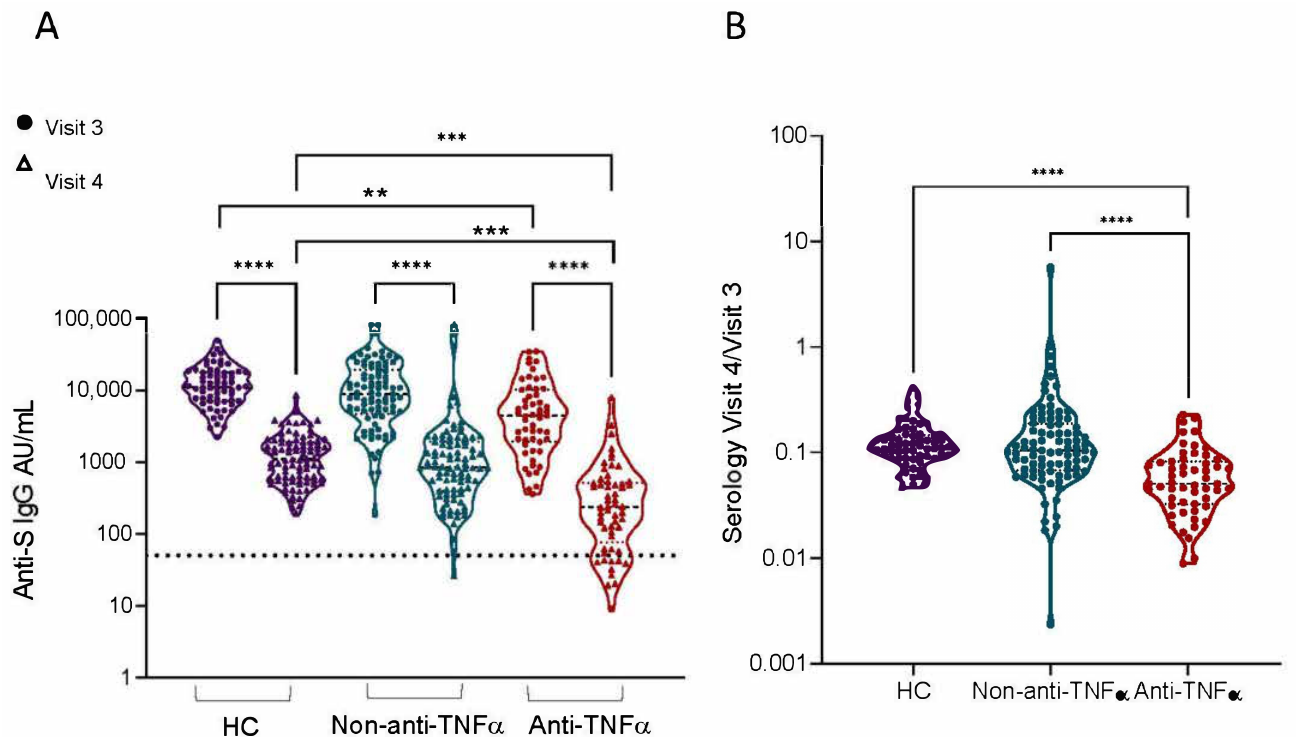
Figure 2. Patients with IBD treated with anti-TNF α showed significantly reduced levels of anti- S levels 6 months after two BNT162b2 vaccine doses. ( A ) Levels of anti-S levels in sera from healthy controls (HCs, shown in purple), patients with IBD receiving non-anti-TNF α treatment (non-anti-TNF α , shown in blue) and patients with IBD receiving anti-TNF α treatment (anti-TNF α , shown in red). Antibodies were measured with the Abbott quantitative anti-S IgG kit. Visits 3 (filled circles) and 4 (open triangles)—after two vaccine doses, 1 and 6 months, respectively. Statistical analysis was carried out using independent sample Kruskal–Wallis test. ****— p < 0.0001, ***— p < 0.001, ** — p < 0.01, Black solid line denotes median, black dashed line denotes IQR25-75. Dotted line represents the threshold for seroconversion (50 AU/mL). Specific GMCs and p -values in Supplementary Table S1. ( B ) Ratio between visit 4 and visit 3 anti-S